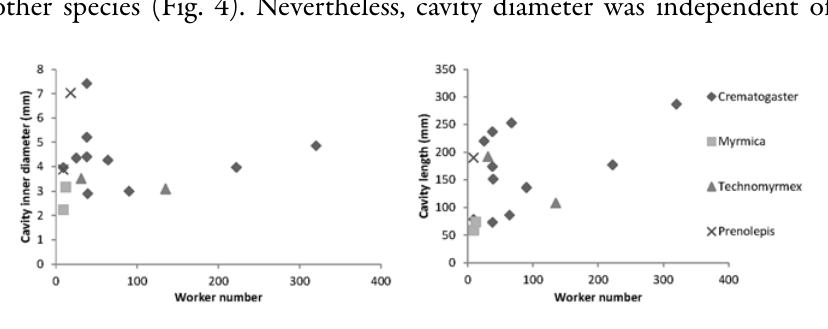
Fig. 4. Worker distribution according to cavity inner diameter (left) and to cavity length (right). C avity diameter was measured at its mid point. Cavity diameter was independent of colony